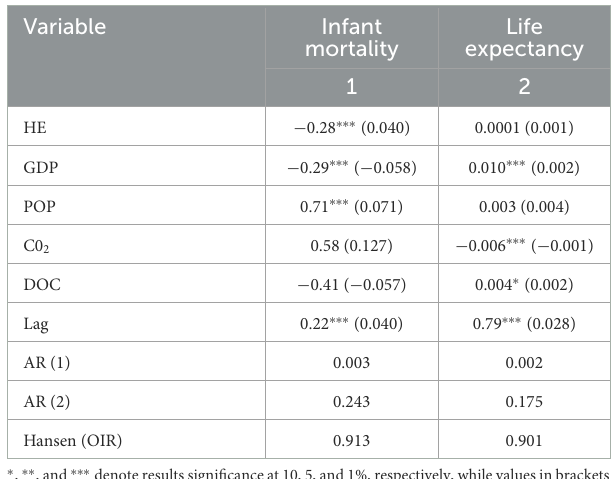
TABLE 3 Results (system